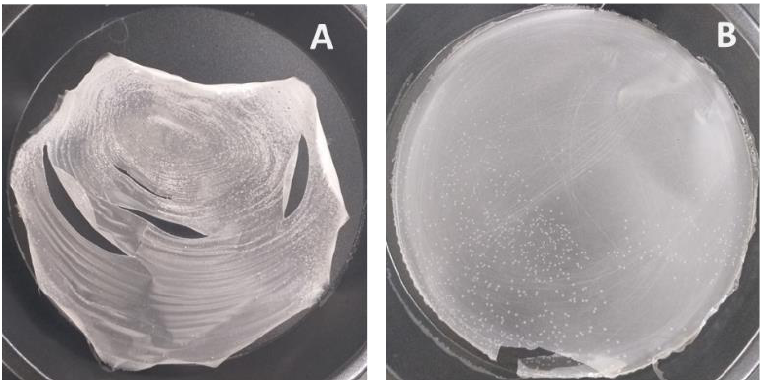
Figure 2. Film-forming property of ( A ) native rice starch and ( B ) crosslinked carboxymethyl rice starch.